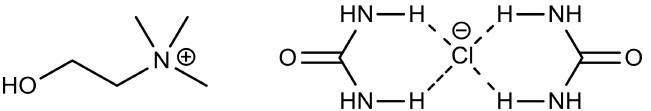
Figure 15. Scheme of the complex formation of a hydrogen bond donor (urea) with a chloride anion in a deep eutectic solvent based on a mixture of urea and choline chloride in a 2:1 molar ratio.